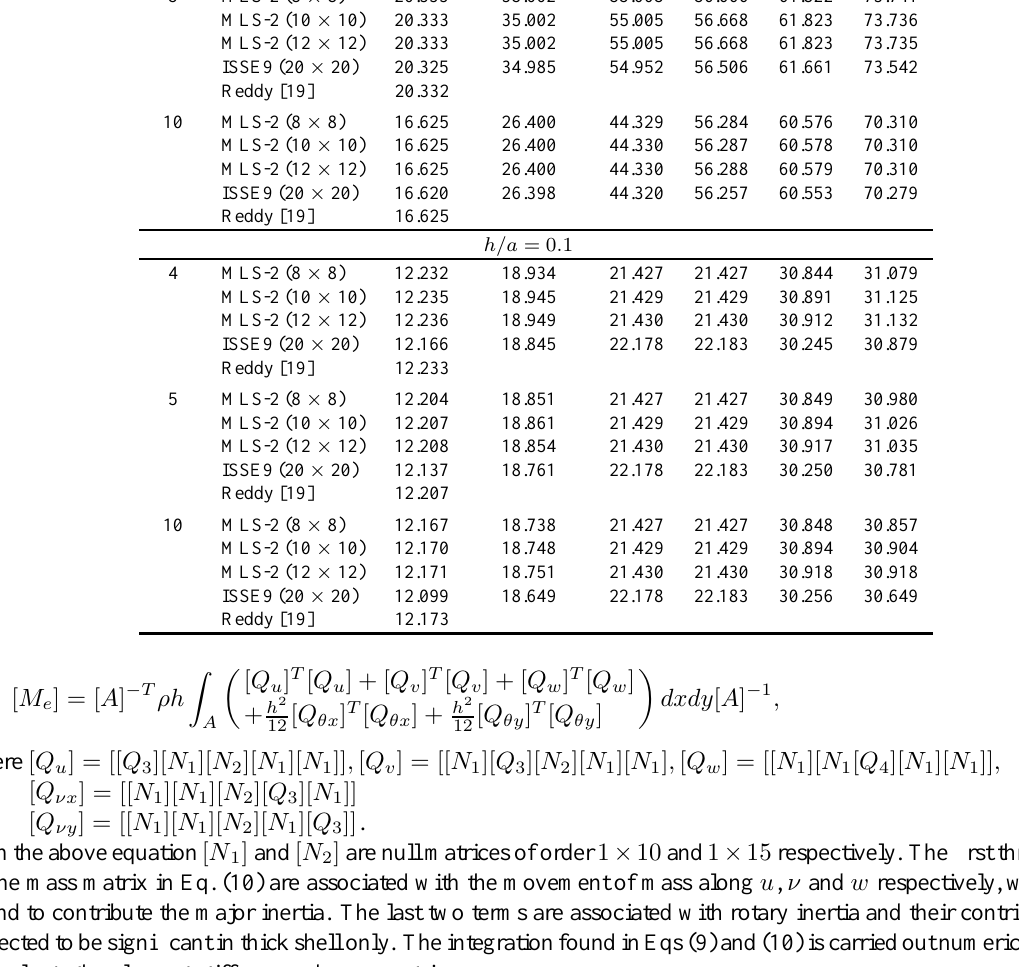
Frequency parameters ( ωa 2